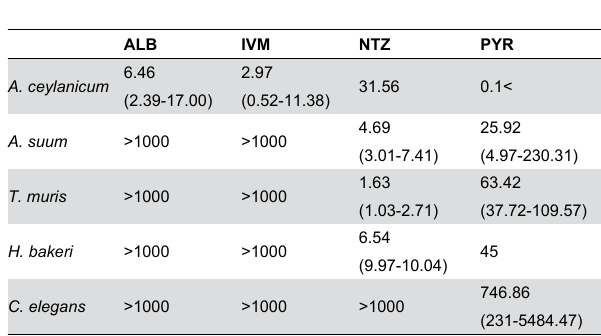
Table 1. IC values (µg/mL) at 4 50